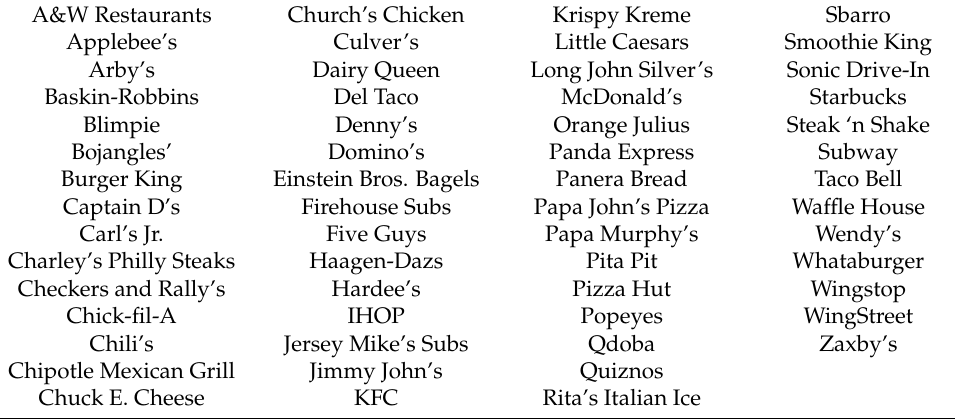
Table A3. A list of full-service restaurants (722,511) considered as less healthy food